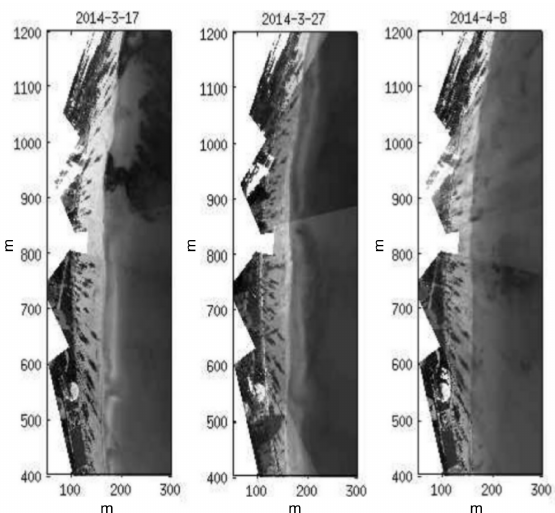
Figure 7. Timex images with dates referred to in each image. Notice the intermediate configuration with a sinuous parallel bar along the coast (ca. 180m) for 17 and 27 March and the dissipative scenario without a bar for 8 April.